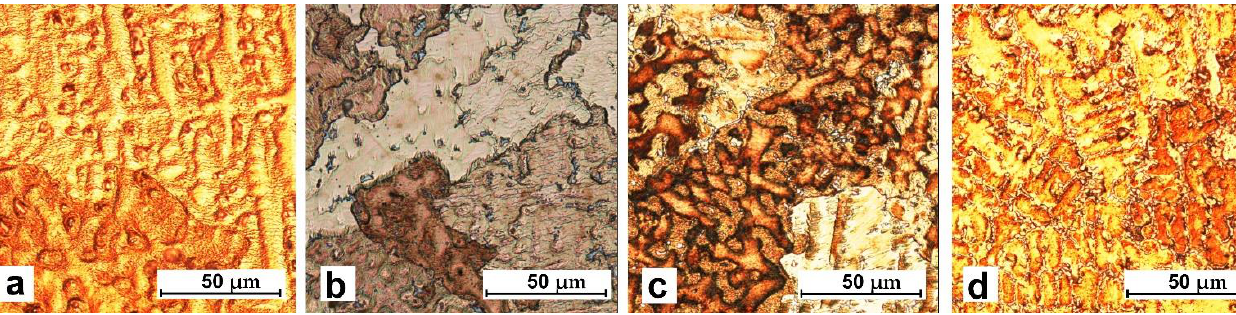
Figure 3. Microstructure of the alloy, metal mould: ( a ) CuSn8; ( b ) CuSn8Ti0.2; ( c ) CuSn8Ti0.7; ( d ) CuSn8Ti2.